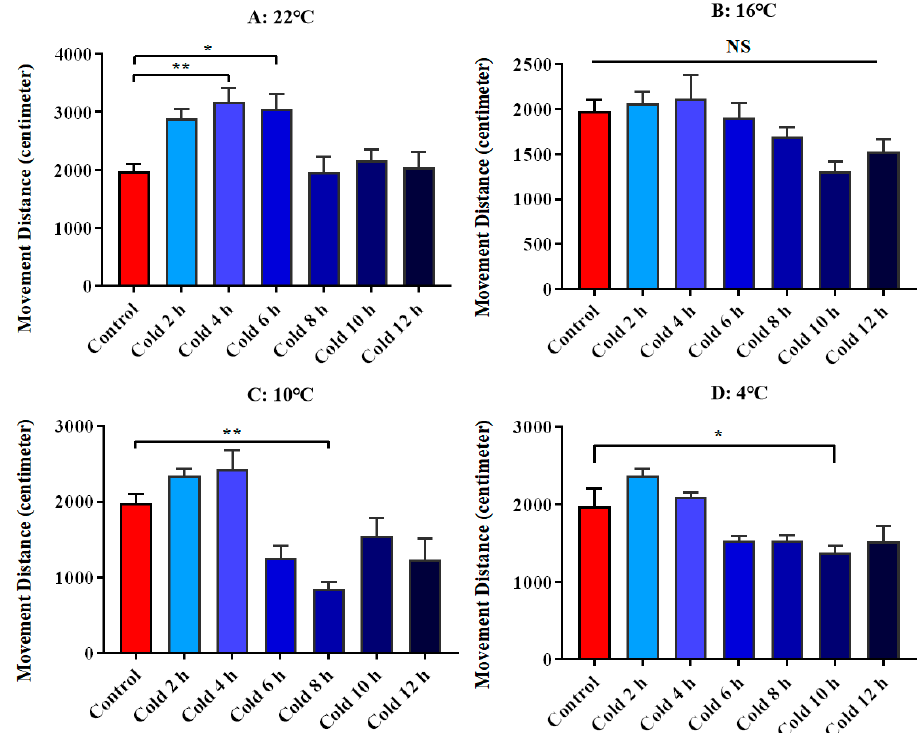
Figure 3. Changes of spontaneous movement of ICR mice under different intensity of cold exposure. ( A ). Changes in the movement distance of mice under cold exposure at 22 ◦ C; ( B ). Changes in the movement distance of mice under cold exposure at 16 ◦ C; ( C ). Changes in the movement distance of mice under cold exposure at 10 ◦ C; ( D ). Change of movement distance of mice under cold exposure at 4 ◦ C. Compared with 28 ◦ C normal temperature control group, the difference was significant as * p < 0.05. ** p < 0.01.